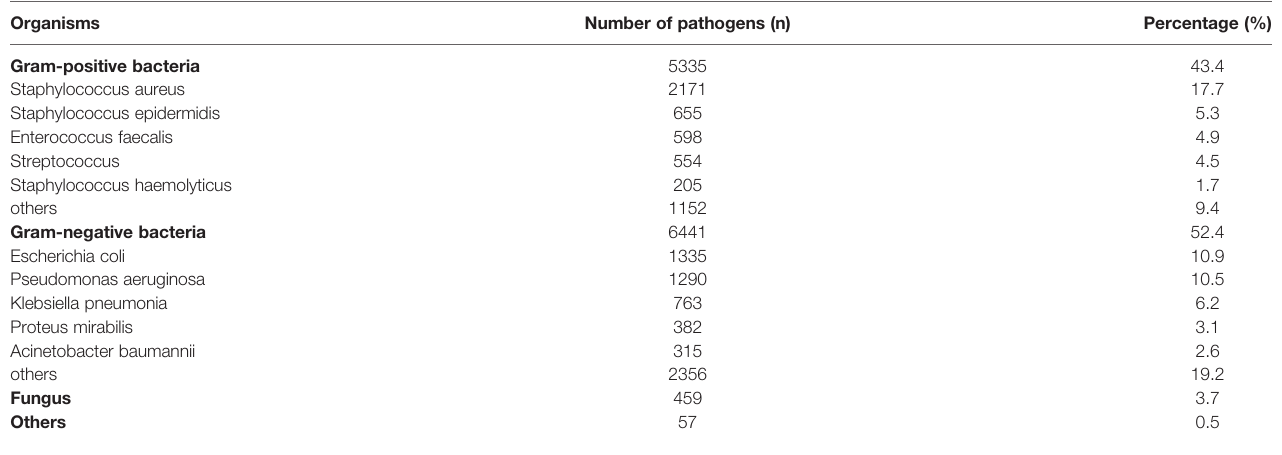
TABLE 1 | Distribution of the pathogenic bacteria isolated from the DFUs.